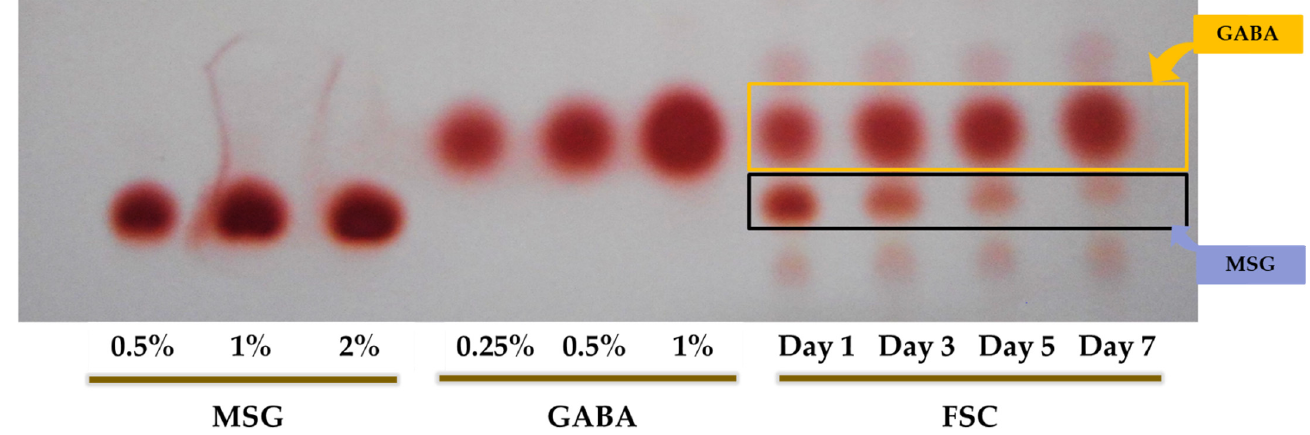
Figure 2. Fermentation effects on GABA production patterns in FSC: Thin-layer chromatogram for MSG standard (0.5–2%), GABA standard (0.23–1%), and two-fold dilution of FSC samples collected at different time intervals (1, 3, 5, and 7 days) during